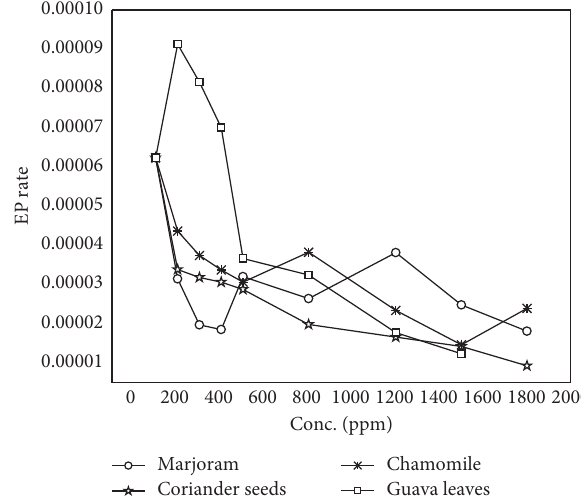
Figure 6: Electopolishing rate values for carbon steel in 8M H containing several concentrations of methanolic plant